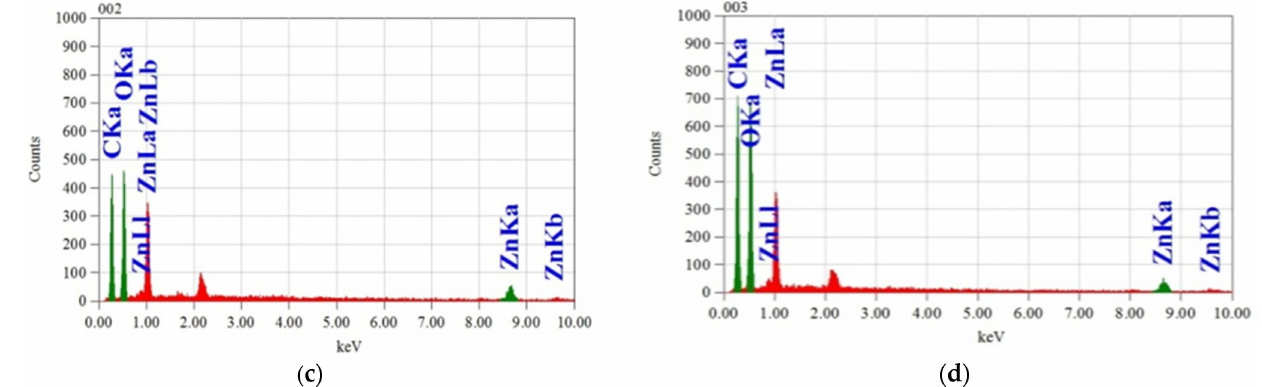
Figure 9. EDS of different samples: ( a ) untreated fabric, ( b ) NanoZnO-1, ( c ) NanoZnO-2, and ( d )